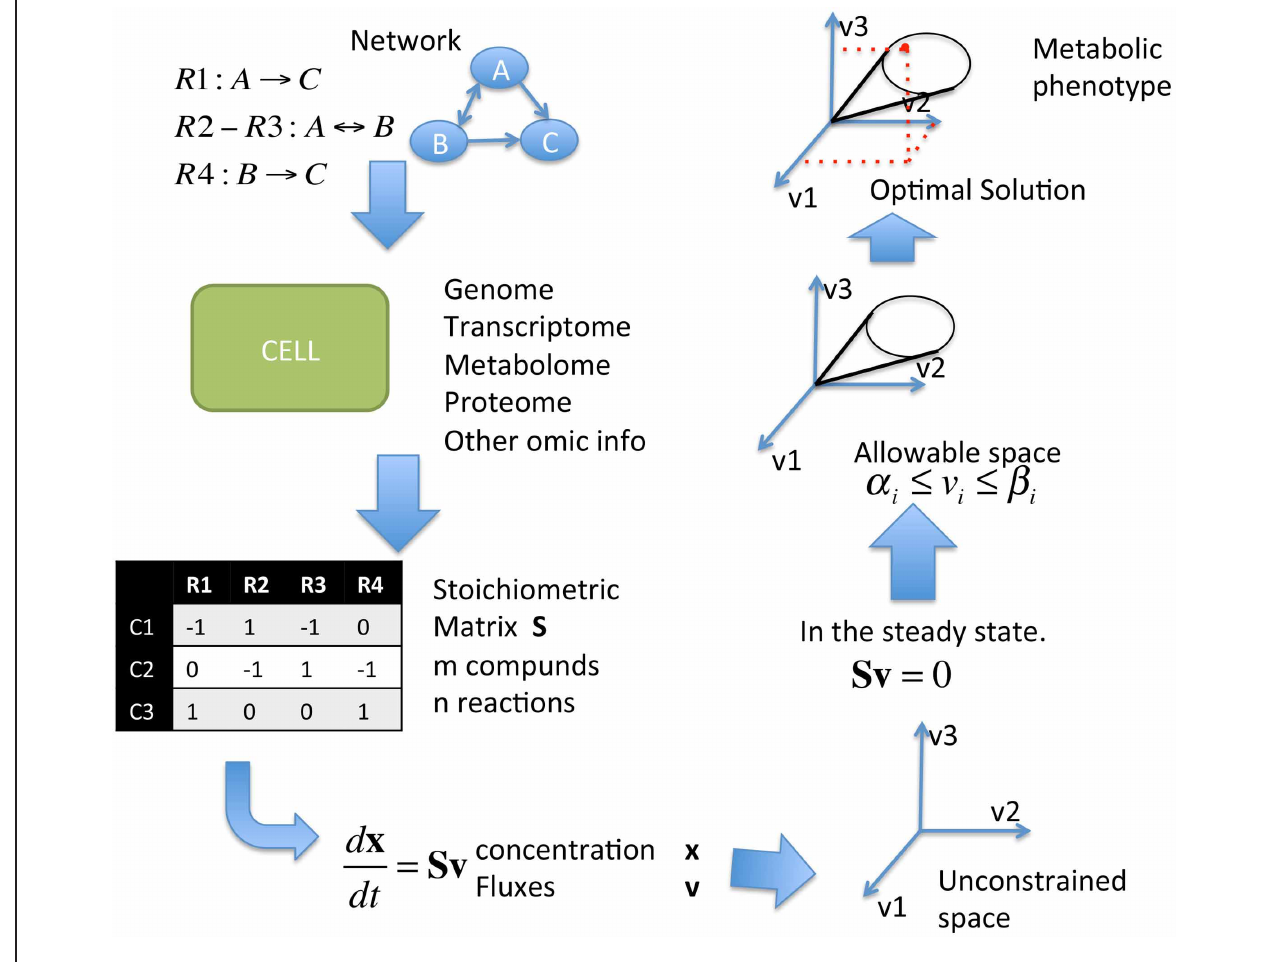
FIGURE 1 | Scheme of Flux Balance Analysis (FBA). First is the definition of the network, HT data is used to complete different levels of information (either in the network, concentration, or fluxes), the network